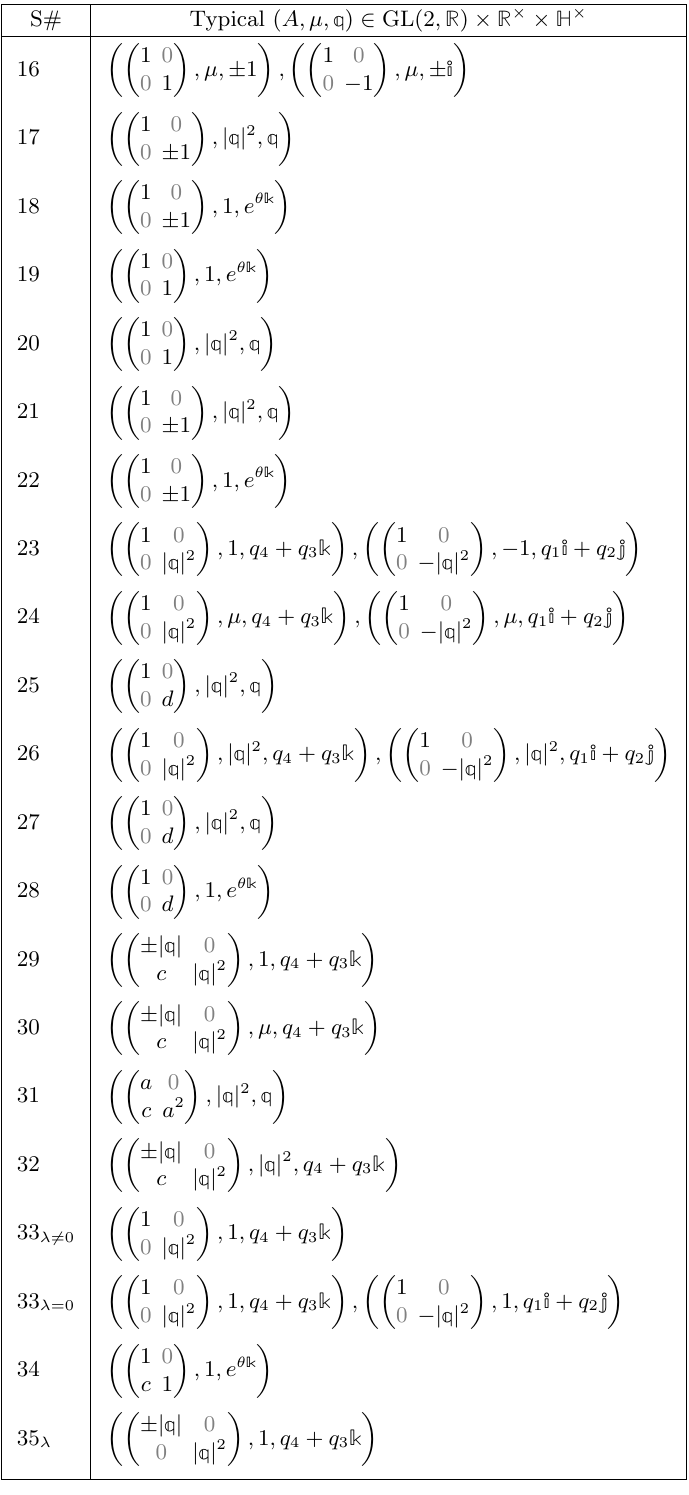
Table 9 . Automorphisms of kinematical Lie superalgebras